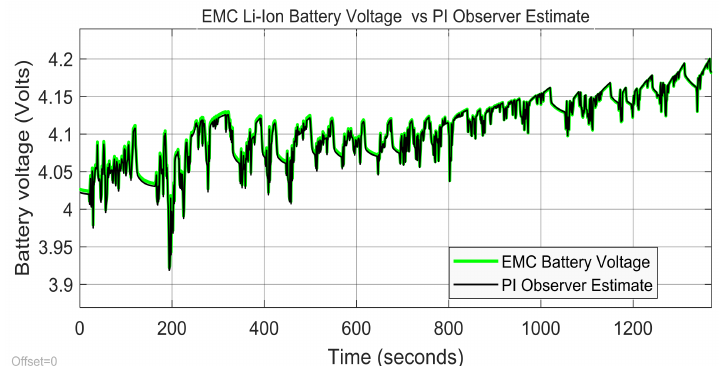
Figure 33. The 2RC EMC Li-Ion battery terminal voltage versus PIO